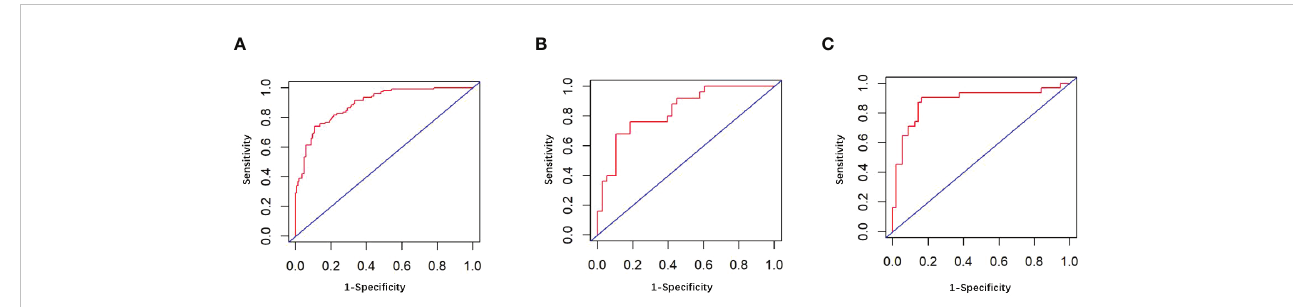
FIGURE 4 (A) The ROC curve in the training cohort; (B) The ROC curve in the internal validation cohort; (C) The ROC curve in the external validation cohort.